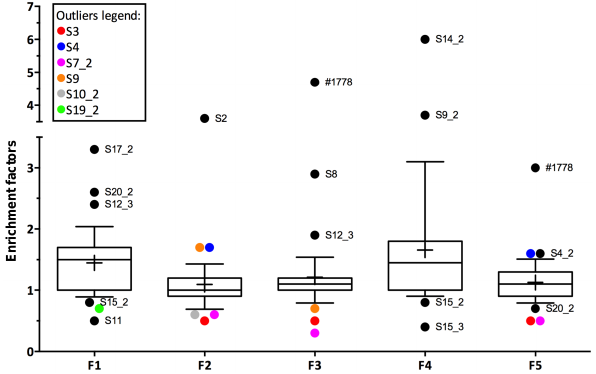
Figure 8. Box and Whiskers plot of enrichment factors for fluores- cent components F1, F2, F3, F4 and F5. The horizontal lines of the boxes represent 25%, 50% (median) and 75% percentiles (from bottom to top). In the boxes, crosses represent the mean. Whiskers represent minimum and maximum values, and circles are outliers. Outliers are staggered to better visualize them. To identify the sta- tion, see outliers’ labels and color legend. For F4, n = 24. For all other components, n = 38.